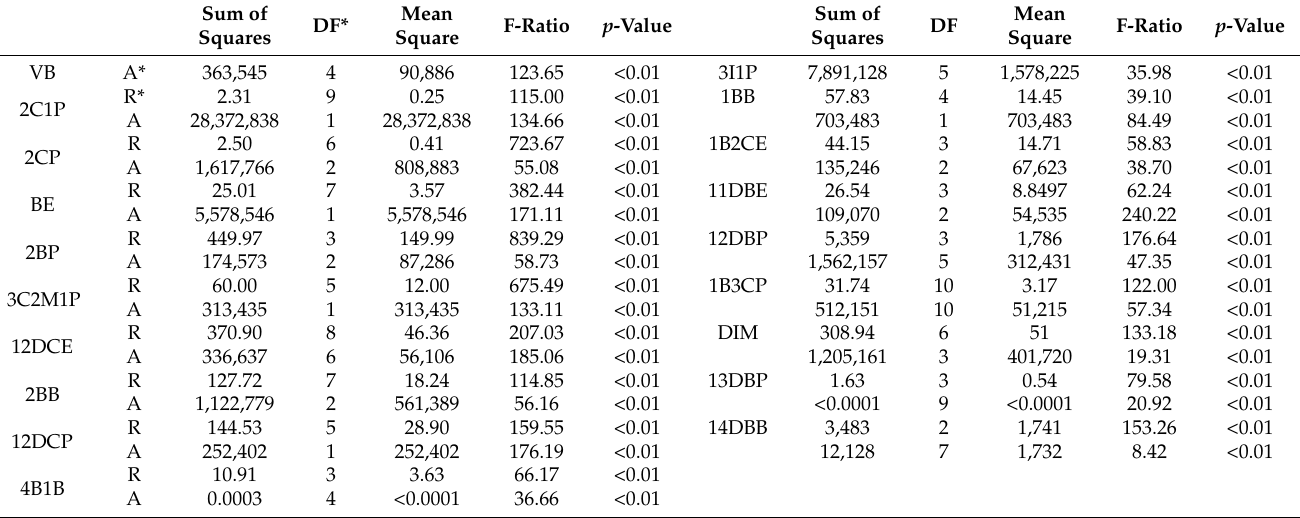
Table 3. Regression analysis of variance analysis (ANOVA) statistics results in the